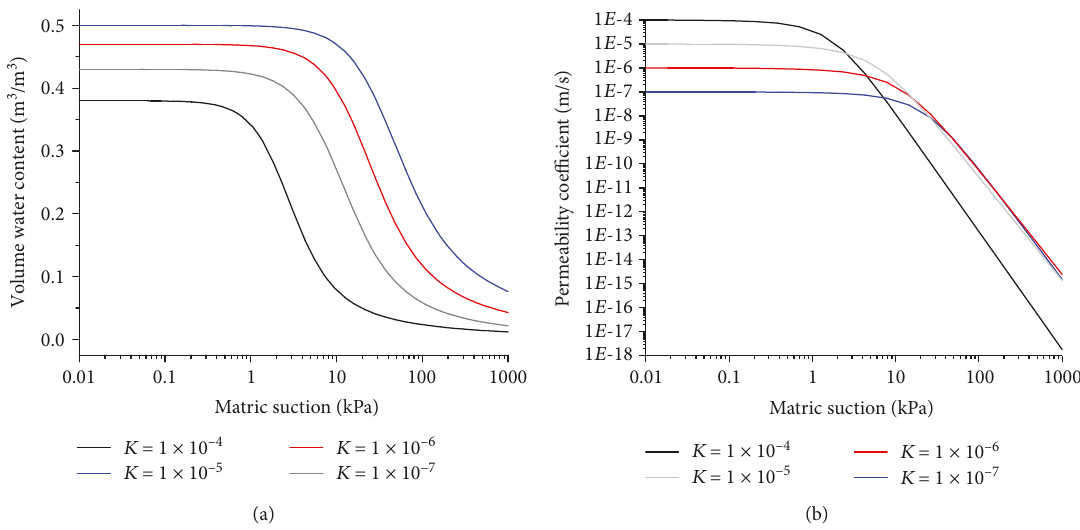
Figure 12: (a) Soil-water characteristic curves and (b) hydraulic conductivity functions of the sliding